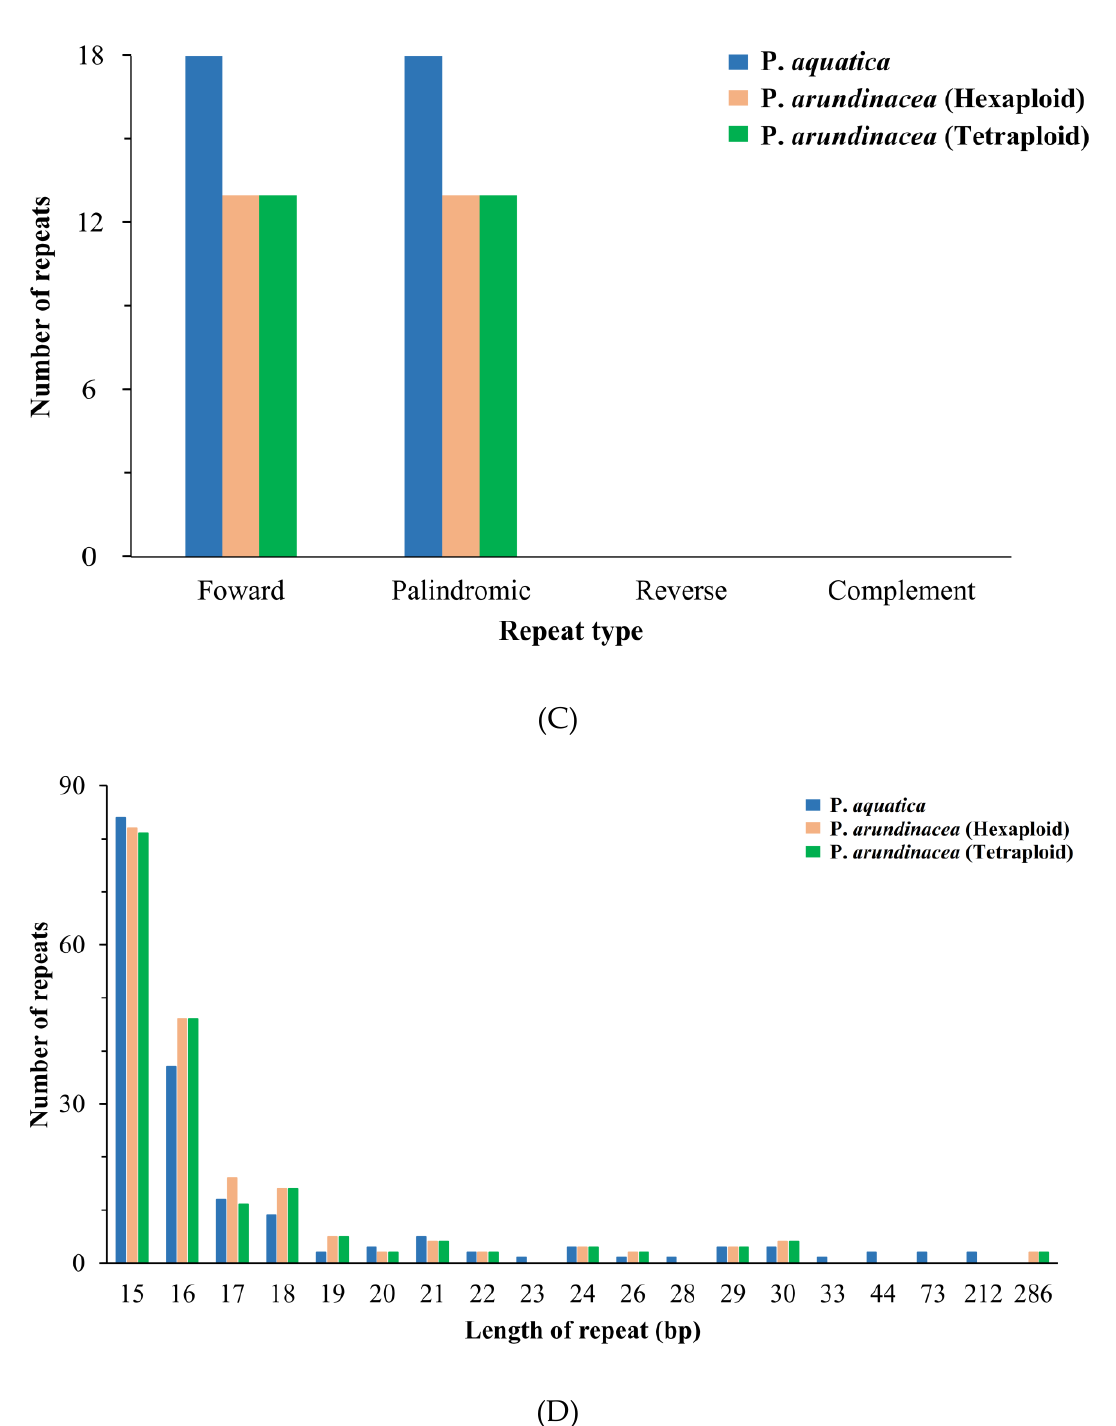
Figure 5. Simple sequence repeats (SSRs) and repeated sequences in the three Phalaris cp genomes. ( A ), SSRs in the different region of Phalaris cp genome; ( B ), motifs in the cp genome of Phalaris ; ( C ), frequency of repeat types; ( D ), frequency of repeats length. ( C ), frequency of repeat types; ( D ), frequency of repeats